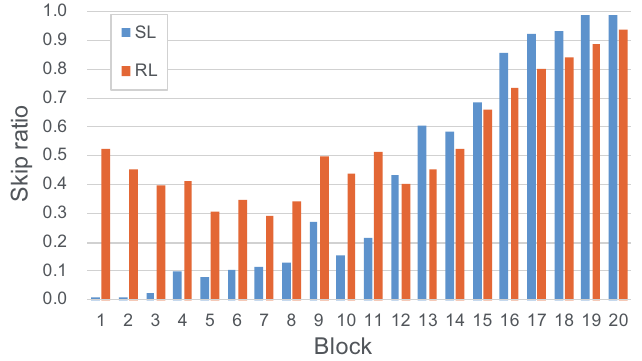
Figure 7. Skip ratio of the DRDN train via supervised learning or reinforcement learning on the RENOIR.